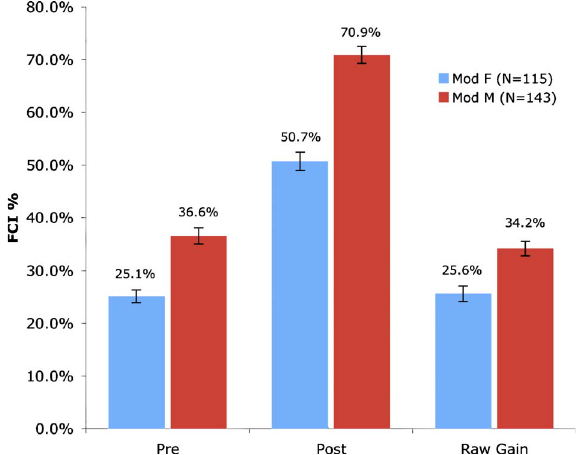
FIG. 5. (cid:1) Color (cid:2) FCI Scores in MI disaggregated by ethnic